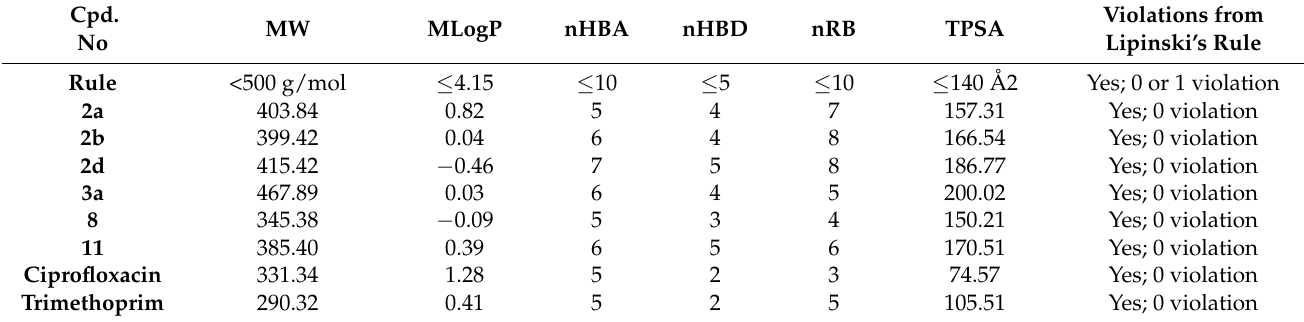
Table 10. In silico physicochemical properties of the newly designed sulfaguanidine derivatives as well as standard drugs.